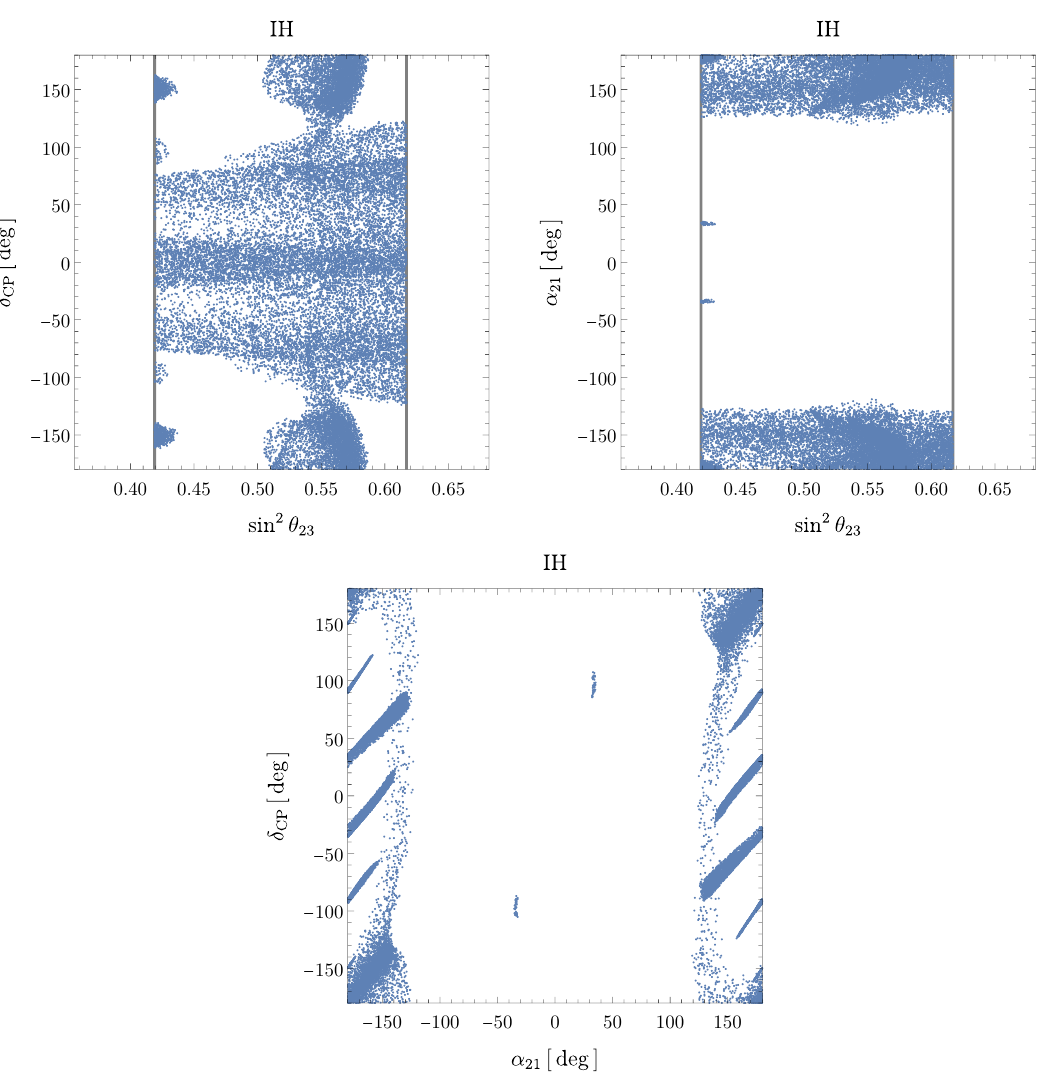
Figure 2 . Predicted CP phases δ CP and α 21 from the allowed parameter sets given in figure 1. The correlations between sin 2 θ 23 and the CP phases (top-left and top-right) and the correlation between CP phases (bottom) are shown. The gray solid lines show the boundaries of the 3 σ region of the experimental